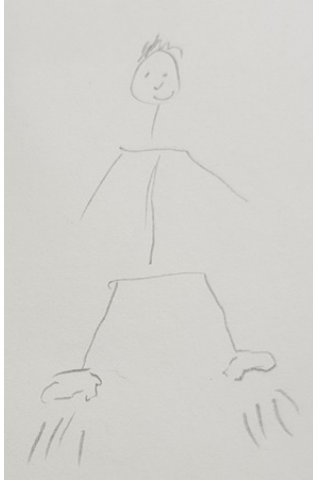
Figure 8. P21’s perception of PD.